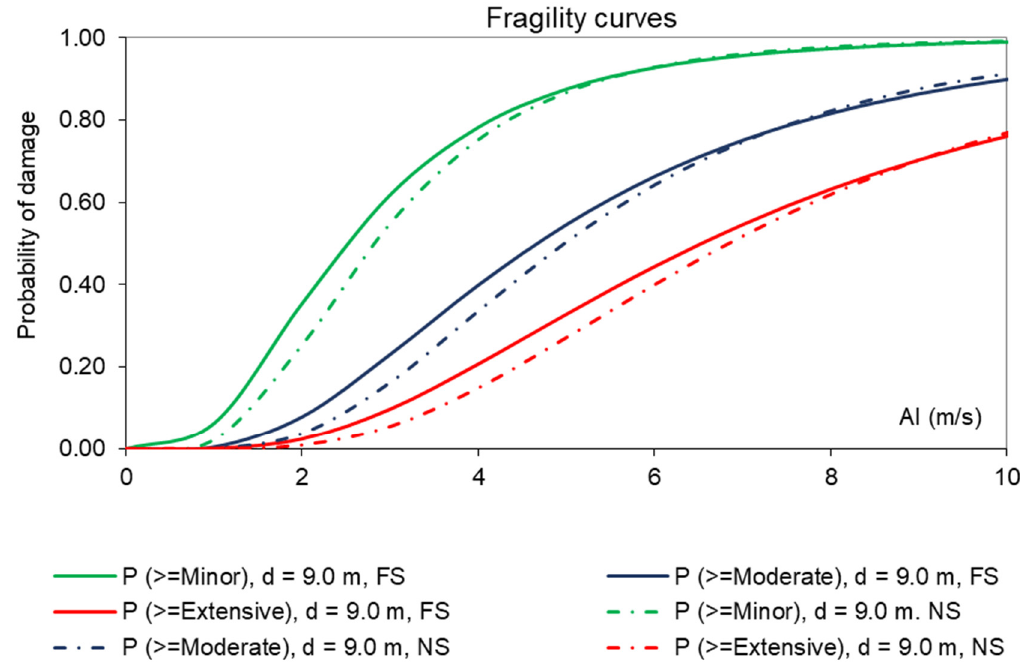
Figure 2. Analytical fragility curves proposed by Huang et al. [53] developed for a circular tunnel in rock for various damage states, assuming no-slip (NS) and full-slip (FS) interface